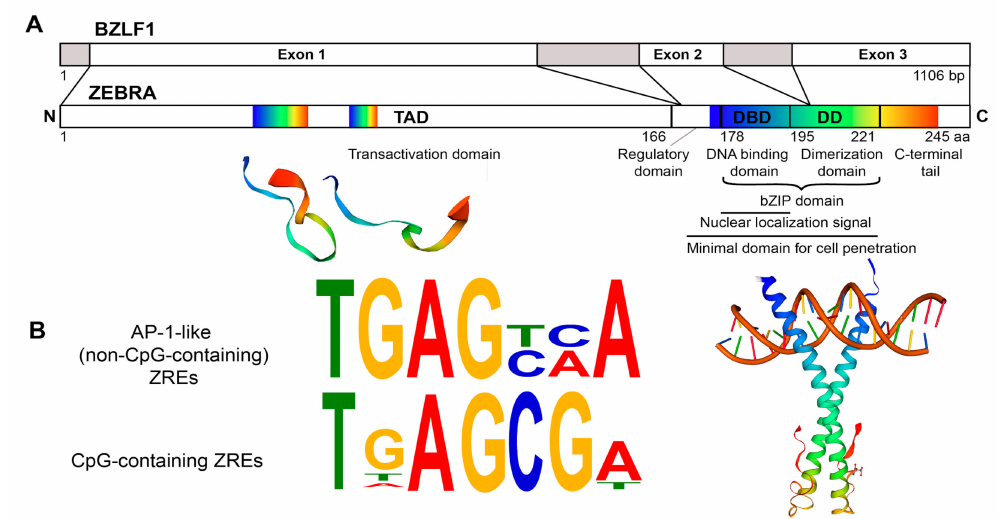
Figure 2. Structure of the ZEBRA protein. ( A ) ZEBRA structure. ZEBRA is encoded by the BZLF1 gene containing three exons. ZEBRA protein has an N-terminal transactivation domain (TAD, residues 1-166), a regulatory domain (residues 167–177), a bZIP domain, which consists of a central basic DNA binding domain (DBD, residues 178-194) and a C-terminal coiled-coil dimerization domain (DD, residues 195–221). The minimal domain for cell penetration is located between residues 170-220. Three available partial 3D structures were imported from the SWISS-MODEL Repository [62] (accession number P03206) and are based on crystal structure data published by [39,42,43]. They are shown below the respective primary sequence. Rainbow color code is used to map approximate residue position concordance between primary and tertiary (or quaternary) structure. ( B ) ZEBRA-response elements (ZREs). Sequences of ZEBRA DNA binding sites (ZREs) of two types: AP-1-like (non-CpG-containing) ZREs and CpG-containing ZREs are depicted as sequence logos, adapted from